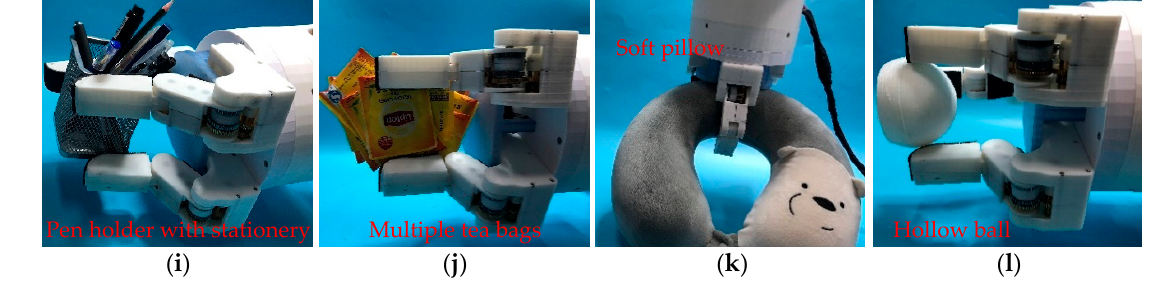
Figure 22. ESMGM hand grasping experiment.